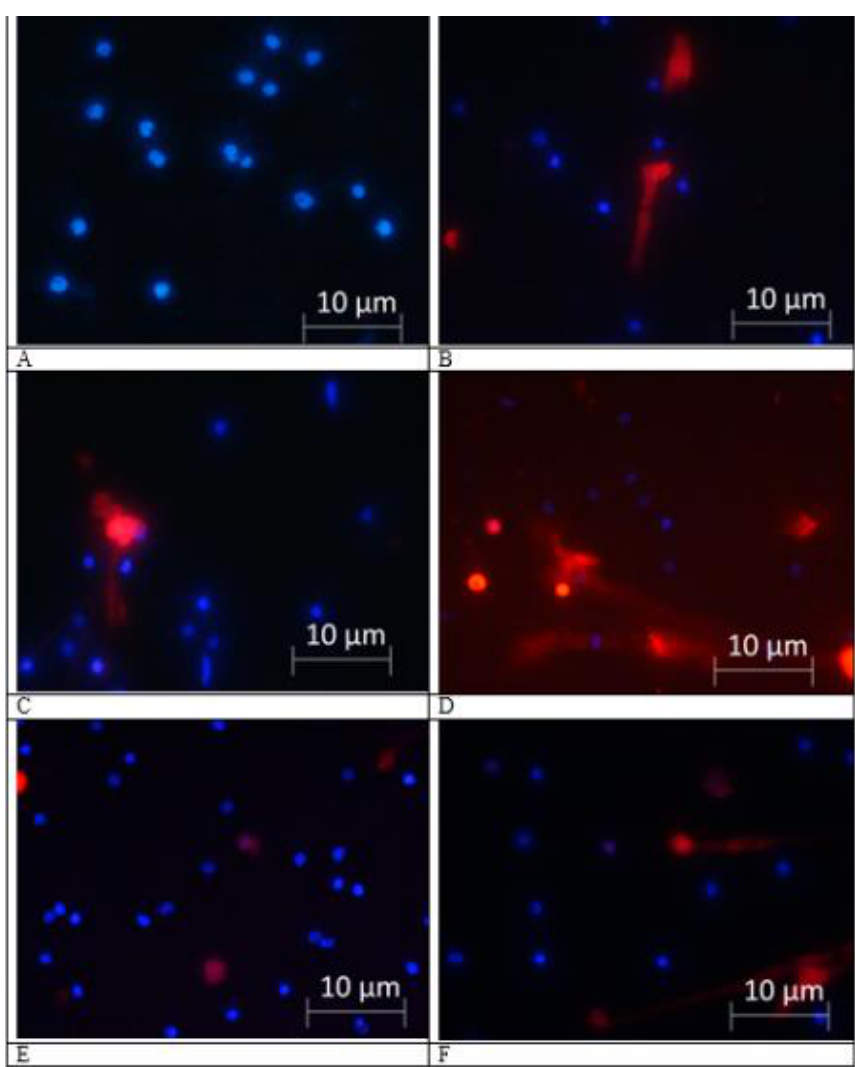
Figure 1. Fluorescence microscopy (40 × magnification) of isolated polymorphonuclear leukocyte (PMN): Spontaneous (left column) and phorbol myristate acetate (PMA)-induced (right column) neutrophil extracellular traps in mild cognitive impairments (MCI) patients. Viable neutrophil nuclear DNA was stained with membrane permeable Hoechst 33342 (blue), and neutrophil extracellular traps (NETs) were visualized by membrane impermeable Propidium Iodide (red) staining extracellular DNA. ( A , B ) PMN from Healthy Control group at baseline time point; ( C , D ) PMN from patient of MCI+IHHT group at pre-IHHT baseline time point; and ( E , F ) PMN from the same patient of MCI+IHHT group one day after the termination of intermittent hypoxia-hyperoxia training (IHHT).